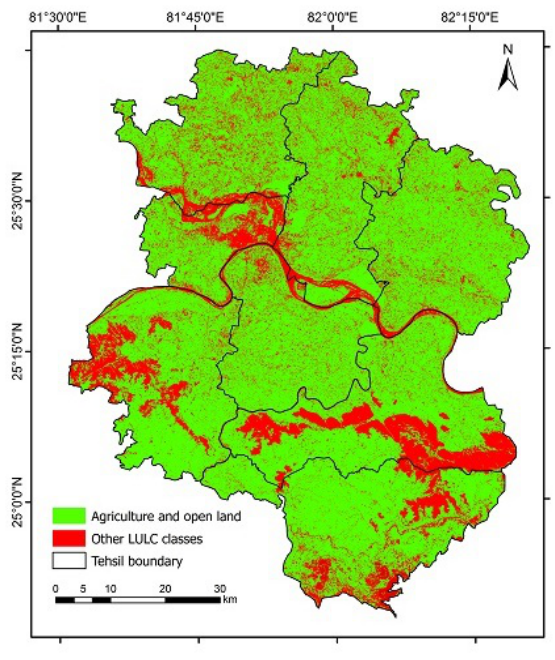
Figure 3. Allahabad district LULC map of year